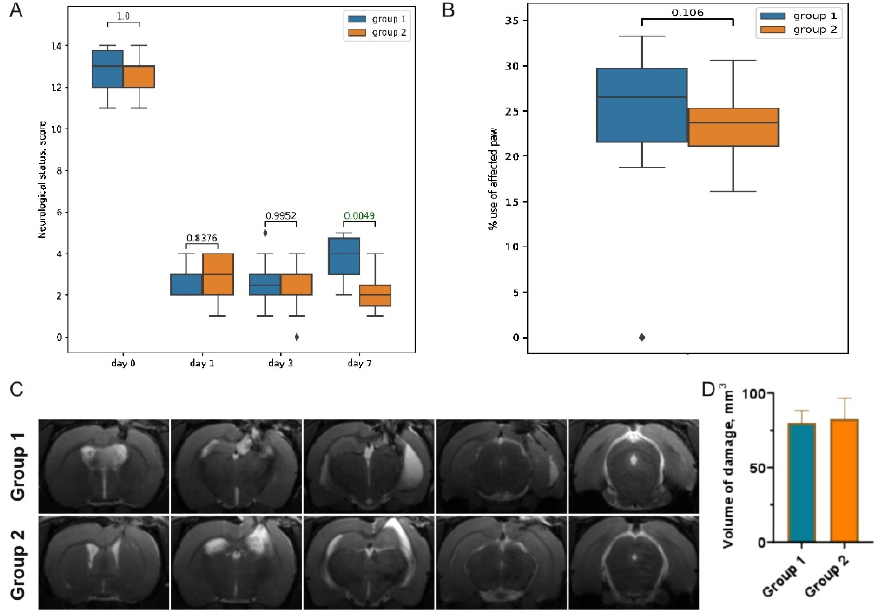
Figure 1. ( A ) LPT scores before (day 0) and on days 1, 3, and 7 after the TBI. Grouping was based on the observed dynamics of neurological recovery. ( B ) TBI-induced forelimb asymmetry measured with the Cylinder Test on day 7 after the TBI. ( C ) Representative T2-weighted MRIs of the coronal brain sections (0.8 mm thick, from rostral (left) towards caudal (right)), taken on day 7 after the TBI. ( D ) Morphometric analysis of the extent of the brain damage evaluated based on T2-weighted images.